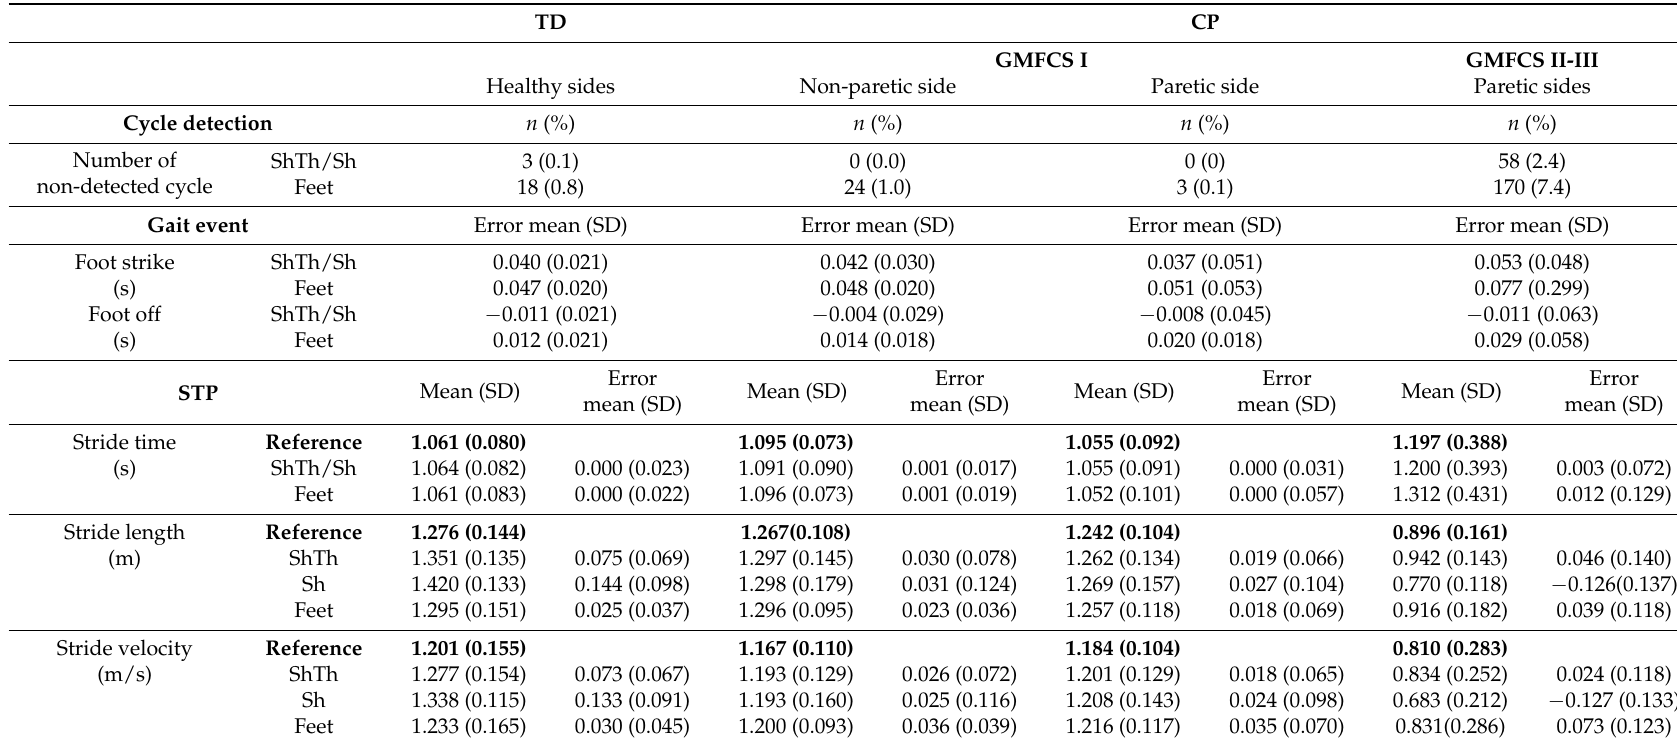
Table 3. Number of non-detected cycles, mean values (and standard deviation), mean errors (and standard deviation) against the optoelectronic system for gait event (Foot strike and Foot off) detection and spatiotemporal parameters (stride time, stride length, and stride velocity) computation. Positive/negative values stand for late/early gait event detection respectively and over/underestimation of STP. Reference values are in